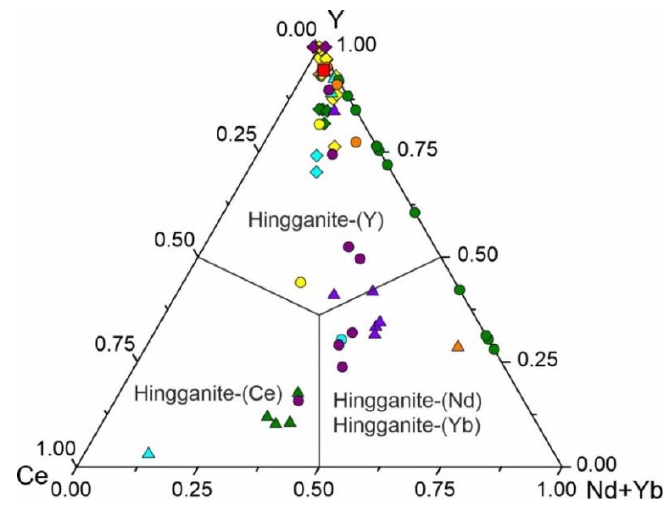
Figure 4. Classification diagram of the hingganites. Symbols are the same as in Figure 2.